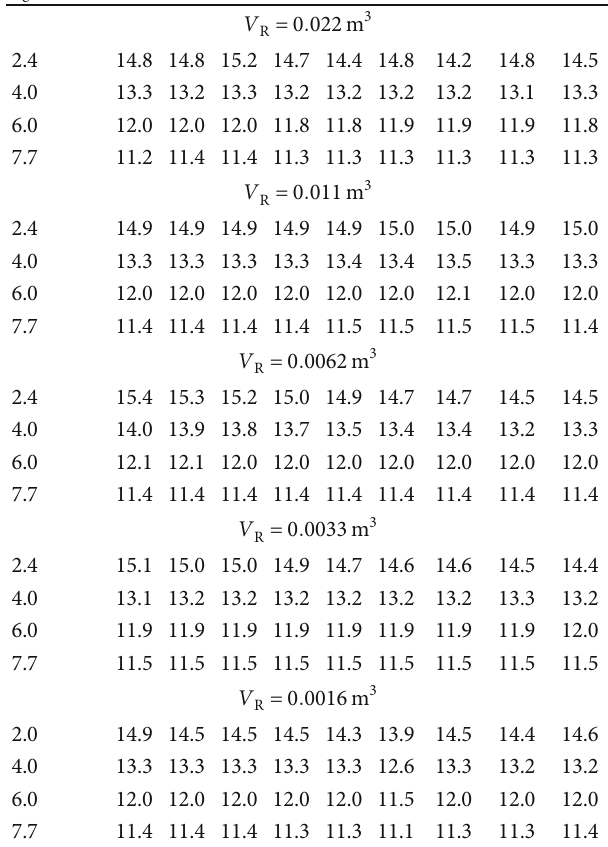
p ffiffiffiffiffi ε E Table 2: Variation of 1/ as a function of the nominal gust frequency, f N , vent hole radius, R , and volume of the air vh g reservoir, V R